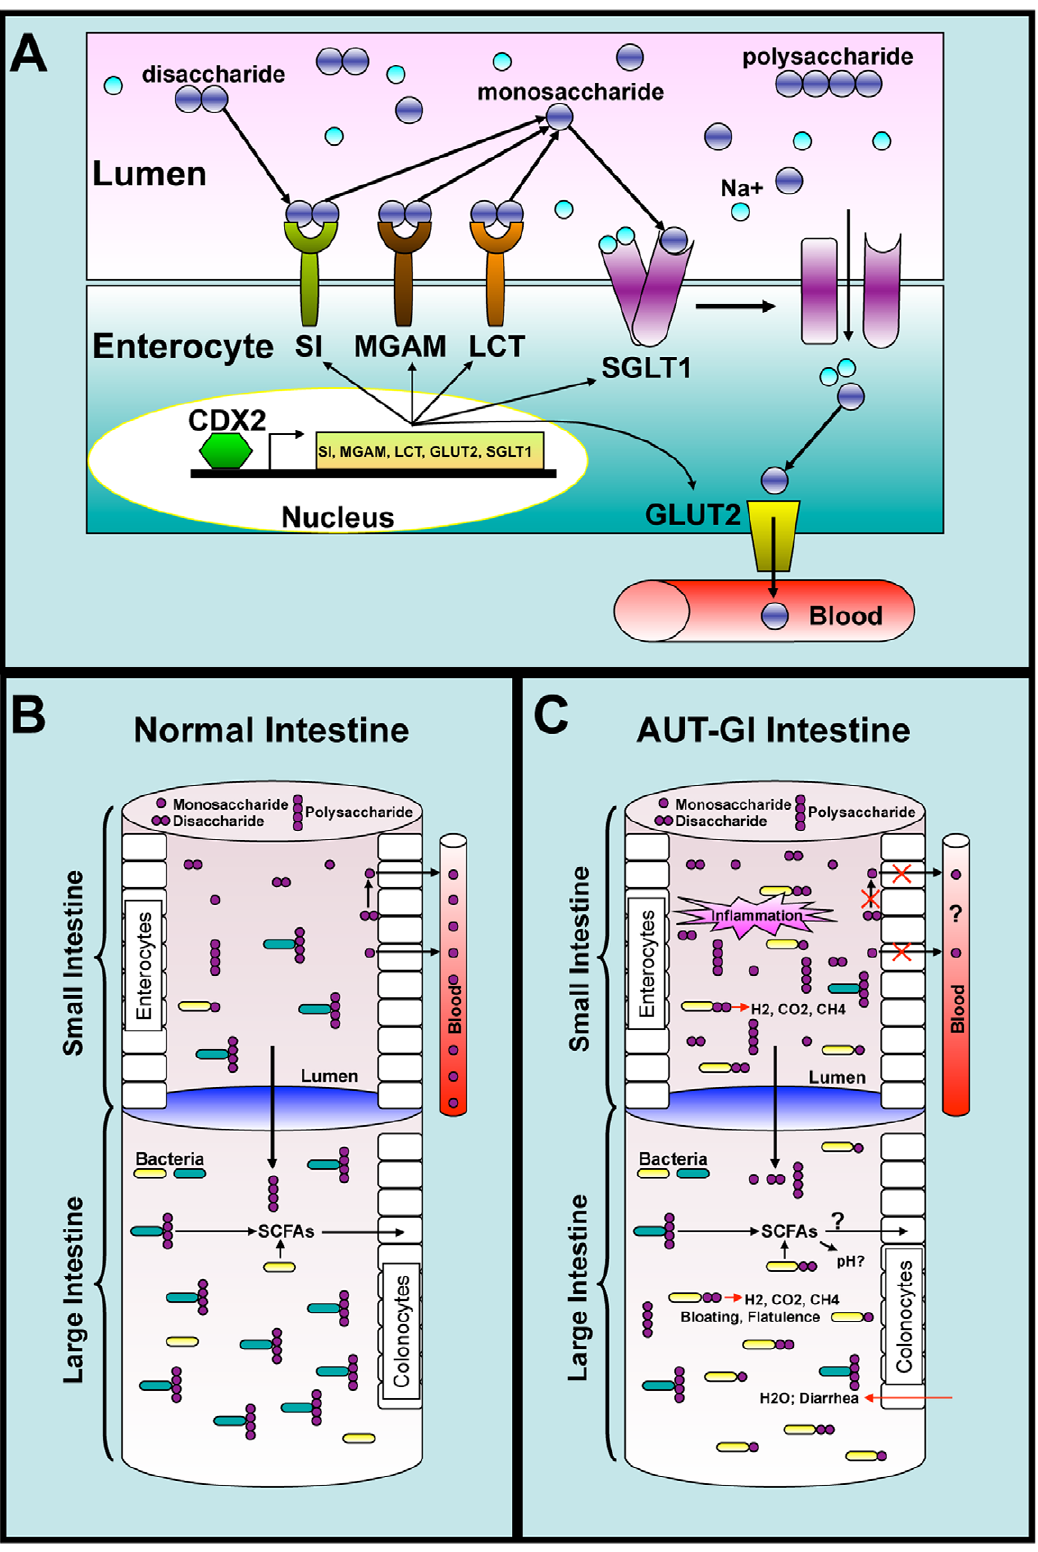
Figure 7. A model for GI disease in children with autism. A ) Schematic representation of enterocyte-mediated digestion of disaccharides and transport of monosaccharides in the small intestine. Disaccharidases (SI, MGAM, and LCT) in the enterocyte brush border break down disaccharides into their component monosaccharides. The monosaccharides, glucose and galactose, are transported from the small intestinal lumen into enterocytes by the sodium-dependent transporter SGLT1. On the basolateral enterocyte membrane, GLUT2, transports glucose, galactose, and fructose out of enterocytes and into the circulation. The expression levels of disaccharidases and hexose transporters may be controlled, in part, by PLoS ONE |